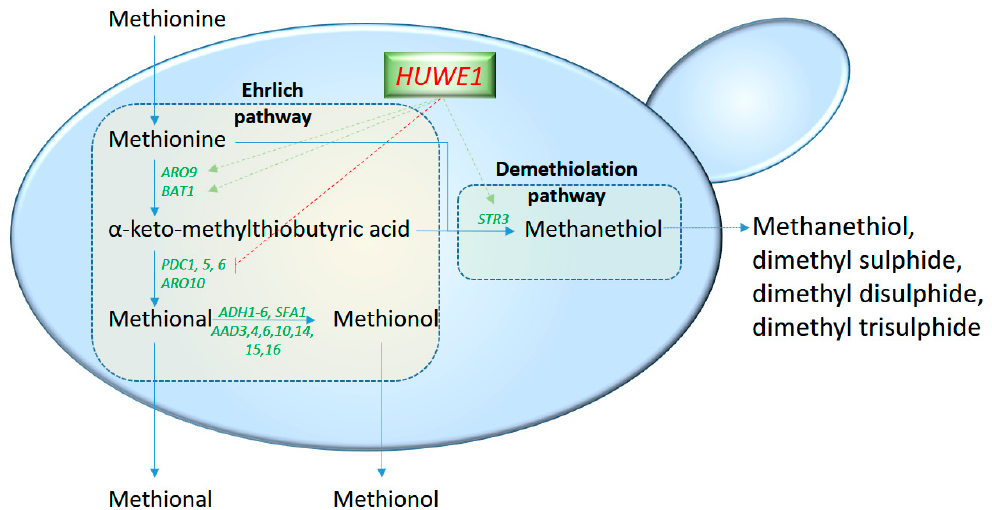
Figure 2. Overview of Huwe1-mediated regulation of the Ehrlich and demethiolation pathways. E3 ubiquitin-protein ligase Huwe1, a key constituent of the ubiquitin-proteasome system, increases the expression of the genes ARO9 and BAT1 of the Ehrlich pathway and of the demethiolation pathway gene STR3 (green arrows), but suppresses (red arrow) the expression of Ehrlich pathway genes PDC1 , PDC5 , PDC6 , ARO10 in S. cerevisiae [51].